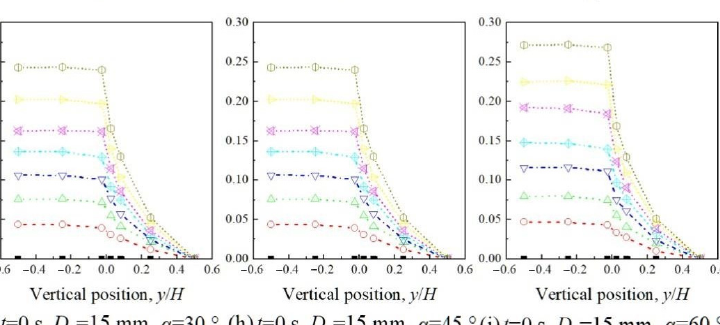
Figure 9. Pressure axial distribution under different conditions: diameter of solid outlets, cone angle and gas superficial velocity.